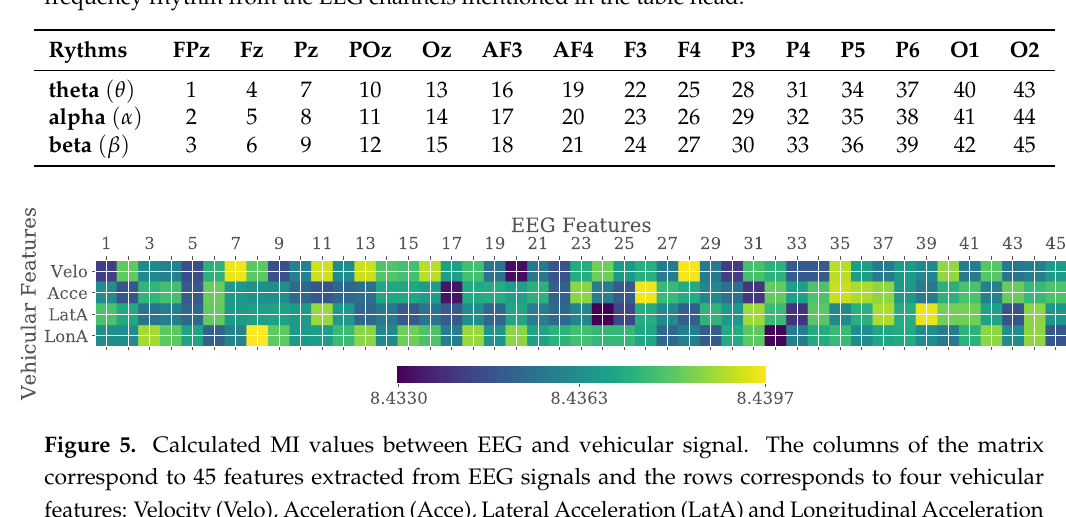
Mapping among different EEG channels, three significant frequency rhythms and identifications (ID) of features. Each row represents the IDs of the features extracted from specific frequency rhythm from the EEG channels mentioned in the table head.